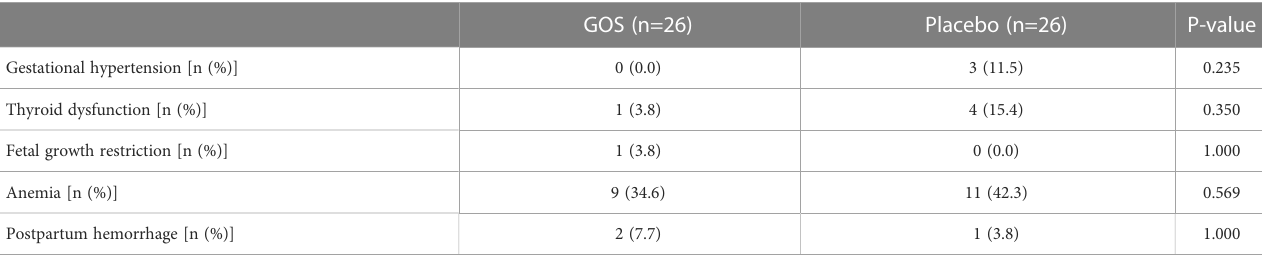
TABLE 6 Incidences of maternal and infant